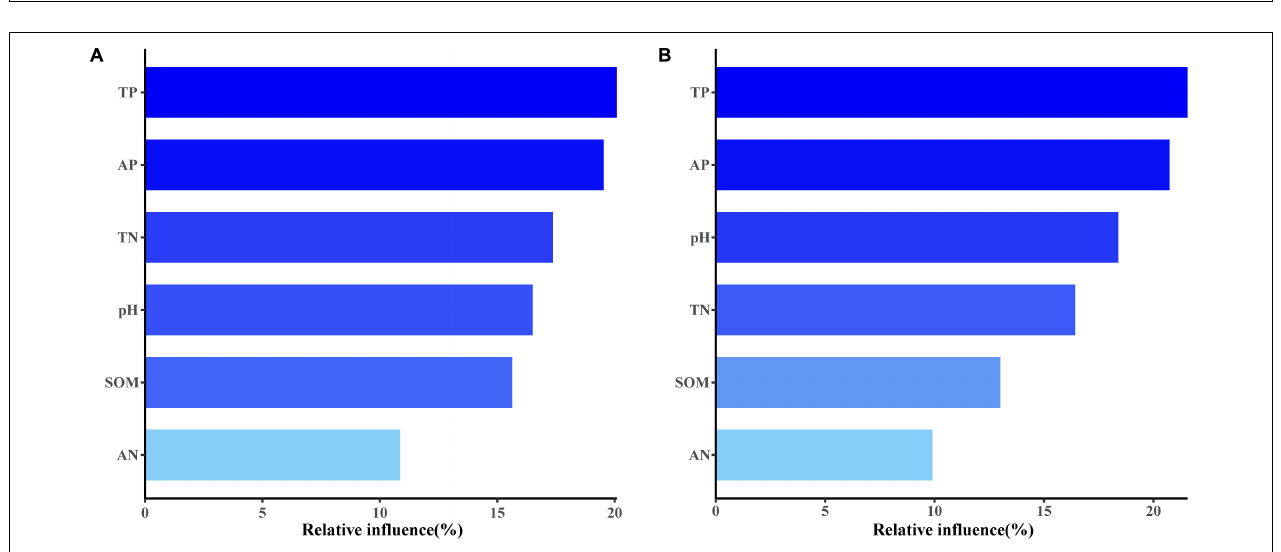
FIGURE 7 | The correlation between soil factors and indices of AM fungal communities on conventional (A) and organic (B) maize farms. The *, **, and *** represents the correlation is significant at P = 0.05, 0.01, and 0.001 level, respectively.